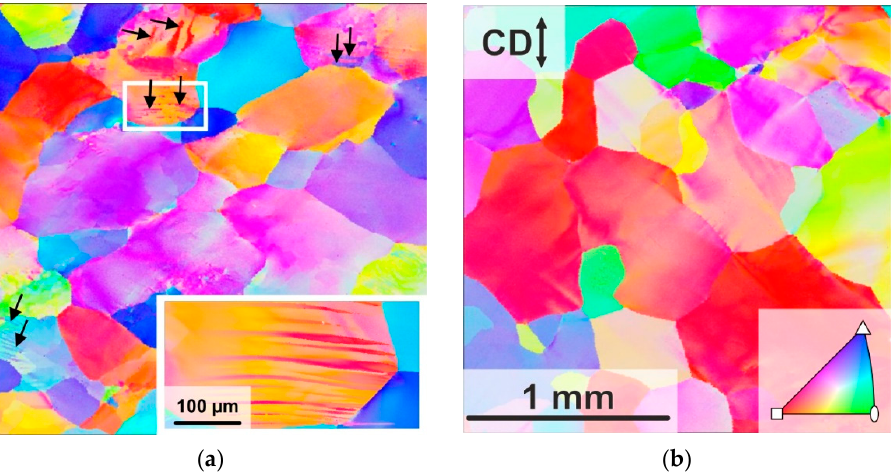
Figure 7. IPF maps of the longitudinal section of deformed HfNbTaTiZr: ( a ) Tested at 873 K ( ε pl , stop = 13.9%). Arrows indicate kink bands. Detail within the white frame is shown at a higher magnification in the inset to highlight kink bands. ( b ) Tested at 1073 K ( ε pl , stop = 16.2%). Both IPF maps have the same size. For magnification, color codes, and CD of both maps, please see labels and inset of Figure